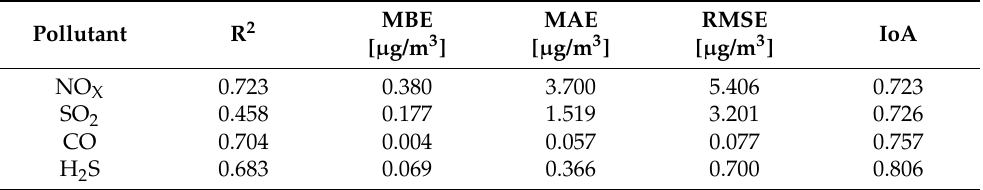
Table 3. Statistical indicators of RF model performances for the testing dataset. Legend: R 2 = coefficient of determination, MBE = mean bias error, MAE = mean absolute error, RMSE = root mean square error and IoA = index of